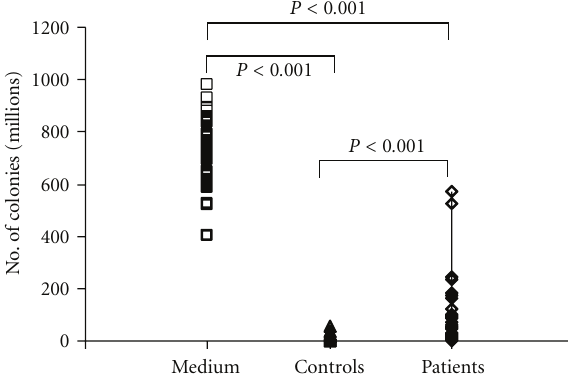
Figure 1: Number of Escherichia coli DH5 α colonies (million cfu/mL) grown on agar plates from the bacterial cell suspension in PBS (Medium) and after the action of serum complements from healthy controls and arsenic patients. Before plating, the bacterial cell suspensions were diluted with PBS to 1:50,000 in Medium, and 1:10,000 both for serum samples from control subjects and arsenic patients. Compared with the Medium, complements from both the sera exhibited highly significant bacteriolytic e ff ects ( P < 0 . 001), while complements from arsenic patients showed significantly diminished bacteriolytic e ff ects compared to the control subjects ( P < 0 .